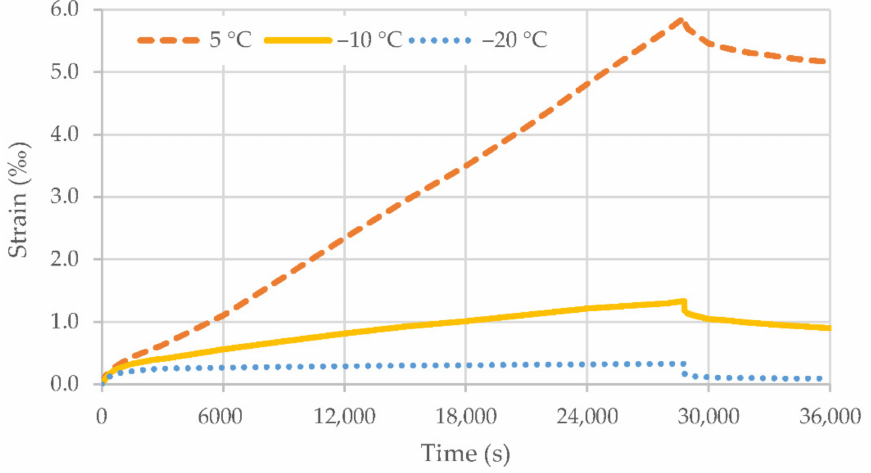
Figure 11. Results of tensile creep tests on the PMB25 mixture at different